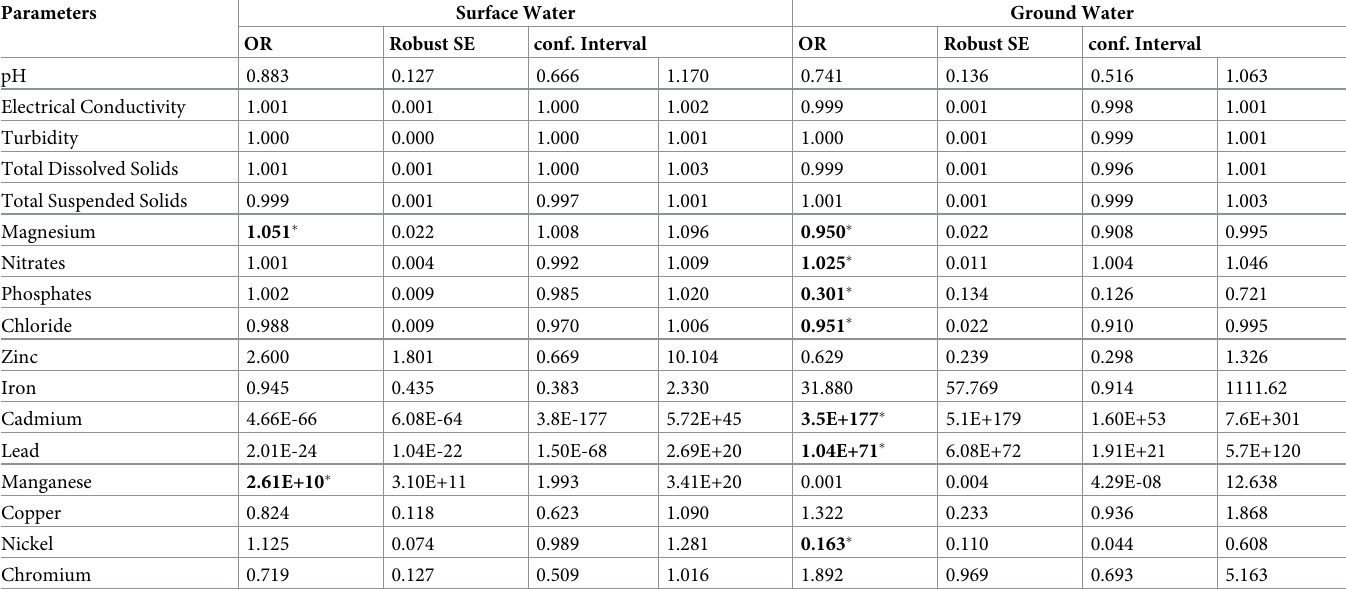
Table 4. Negative log-log bivariate regression of water quality parameters and total